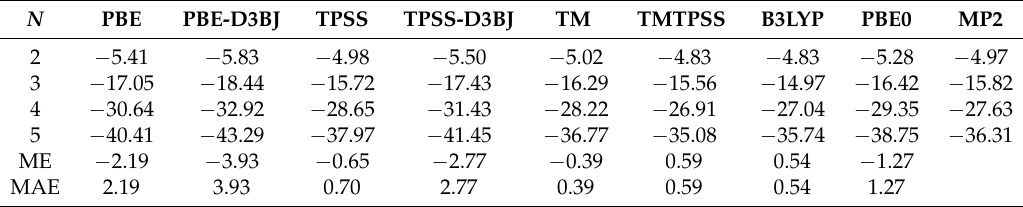
Table 2. Binding energies (kcal/mol) of (H 2 O) n ( n = 2–5) clusters from various DFT methods at the 6-311++G(3 df ,3 pd ) basis set. MP2 values of water clusters are taken from Reference [26].